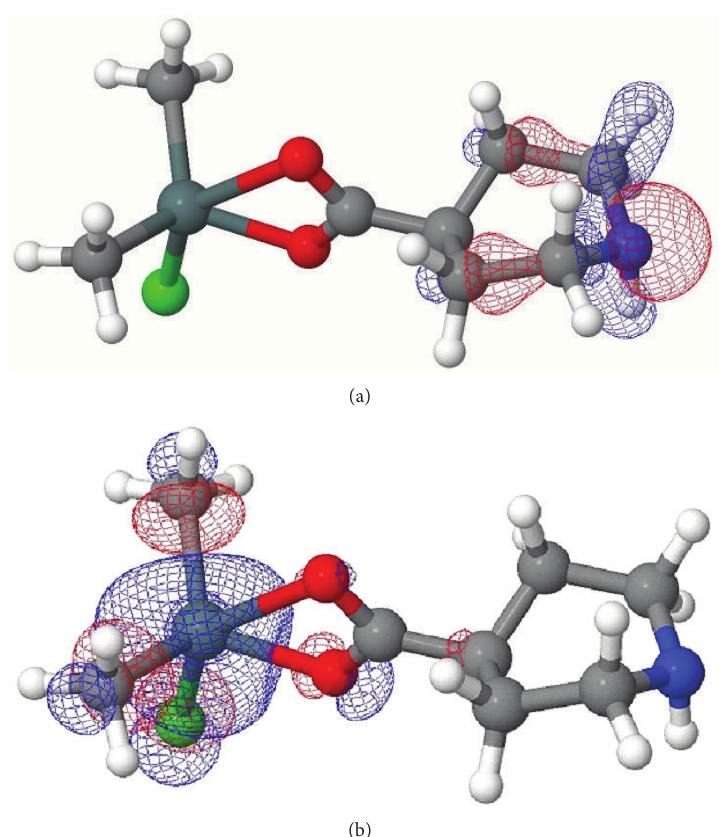
Figure 1: (a) HOMO of complex 1 ; (b) LUMO of complex 1 .